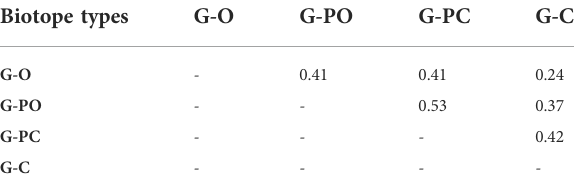
TABLE 2 Jaccard index between biotope types. Biotope